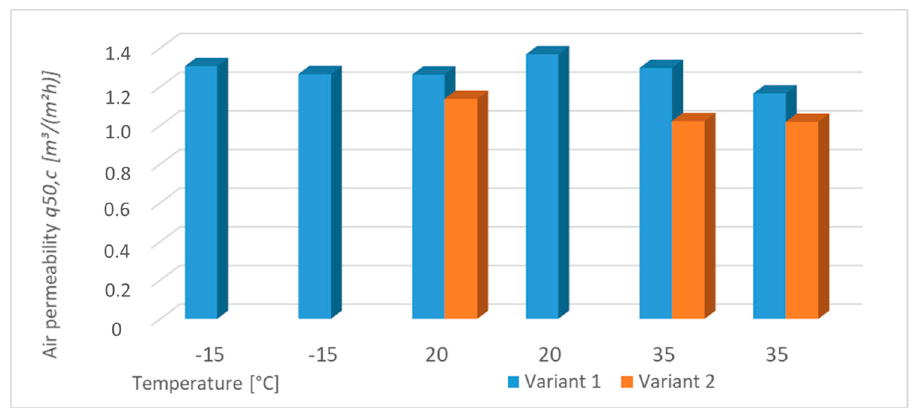
Figure 17. Results of the air permeability for variant 1 and variant 2.